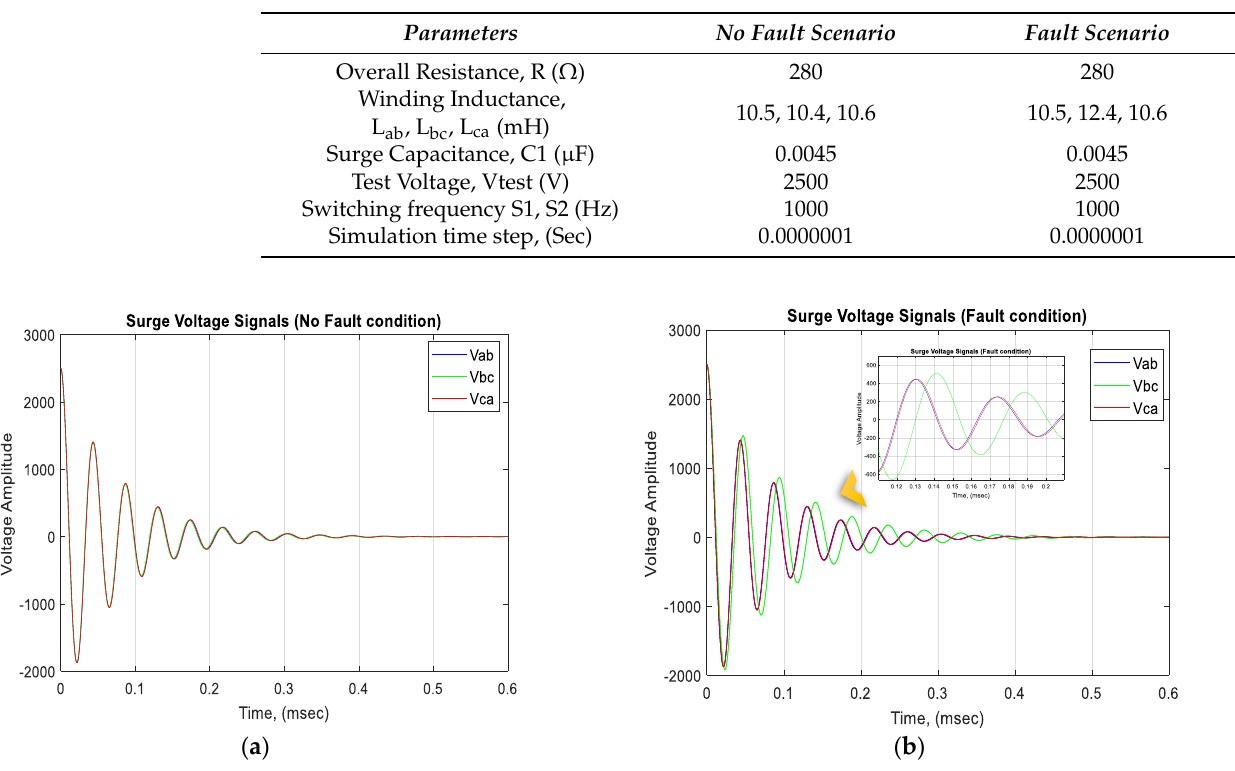
Table 1. Equivalent circuit parameters.